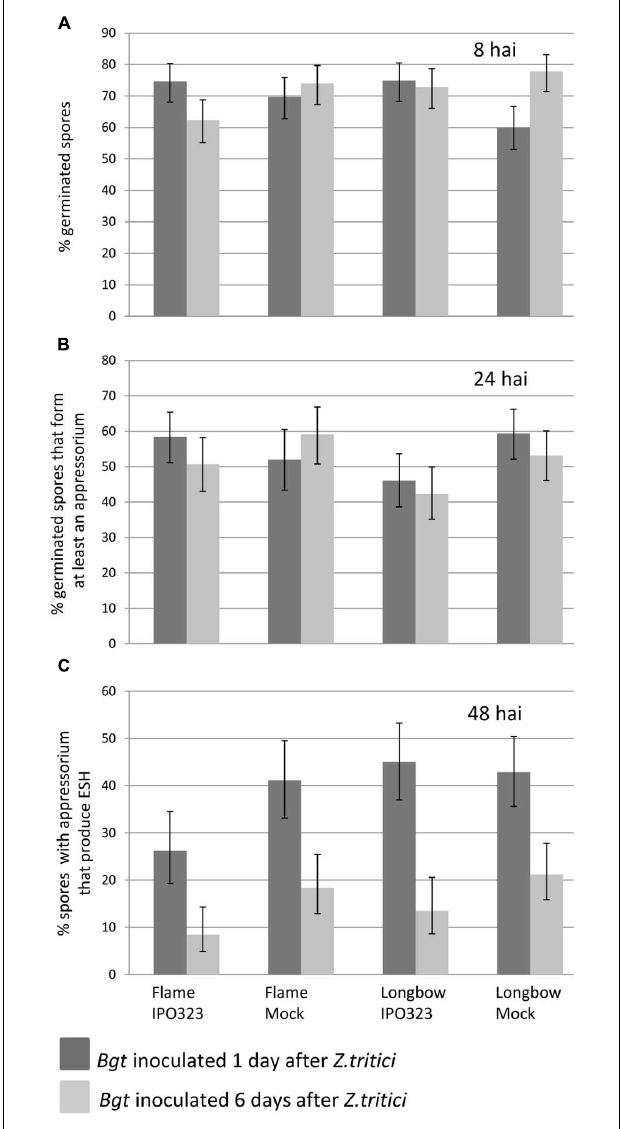
FIGURE 5 | The effect of inoculation with virulent Z. tritici on the early development of B. graminis f.sp. tritici ( Bgt ) on wheat leaves. (A) Percentage of germinated spores 8 h after inoculation (hai) with Bgt . (B) Percentage of germinated spores that form at least an appressorium up to 24/32 hai with Bgt . (C) Percentge of spores which form an appressorium that produce elongated secondary hyphae (ESH) at 48 hai with Bgt . Error bars indicate ± 1 standard error of predicted